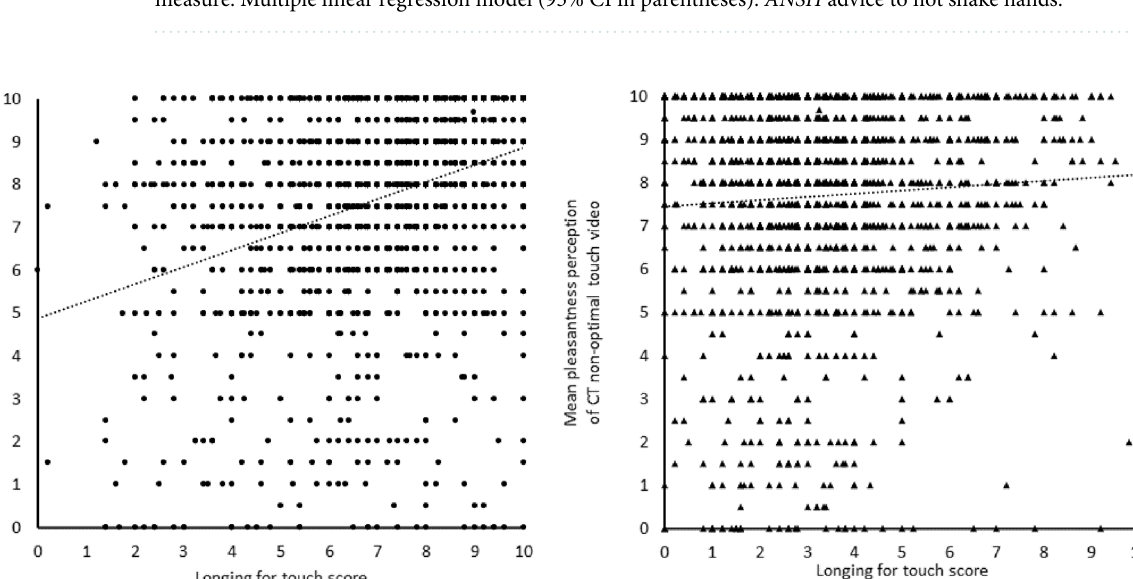
Table 4. Regression coefficients with perceived pleasantness of CT-optimal touch observation as outcome measure. Multiple linear regression model (95% CI in parentheses). ANSH advice to not shake hands.